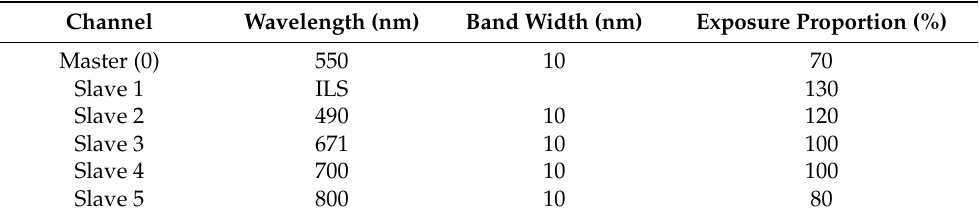
Table 2. The parameters for the sensor of Tetracam